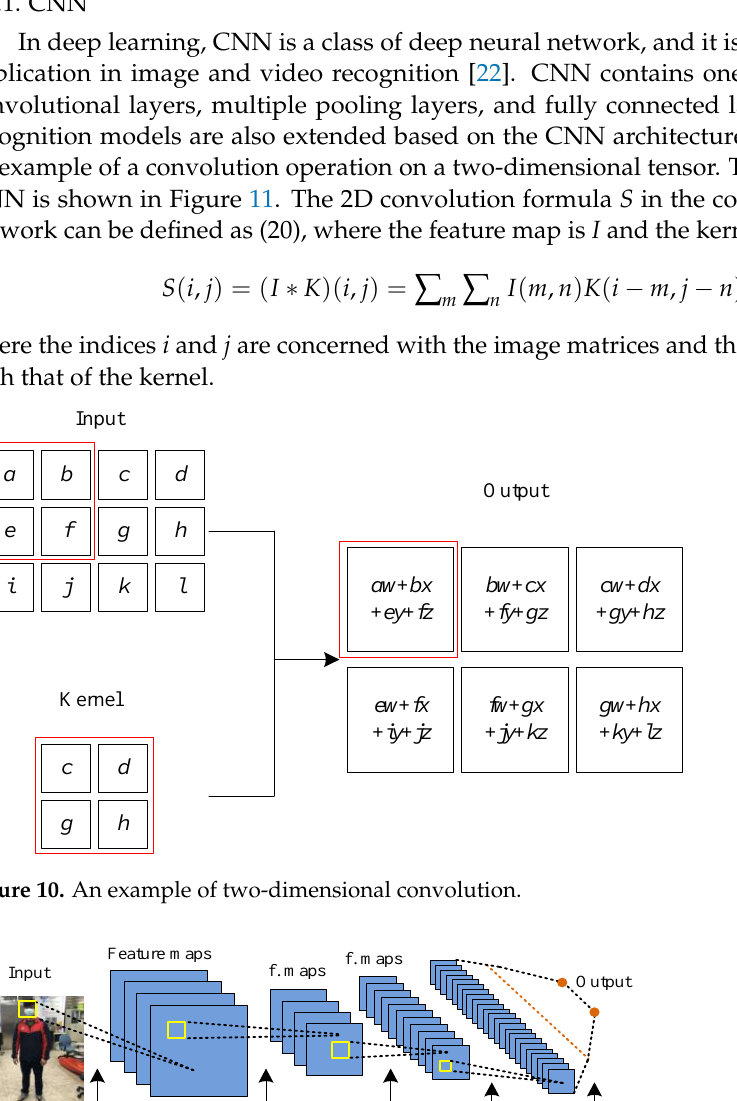
G Figure 12. Bounding-box regression procedure.